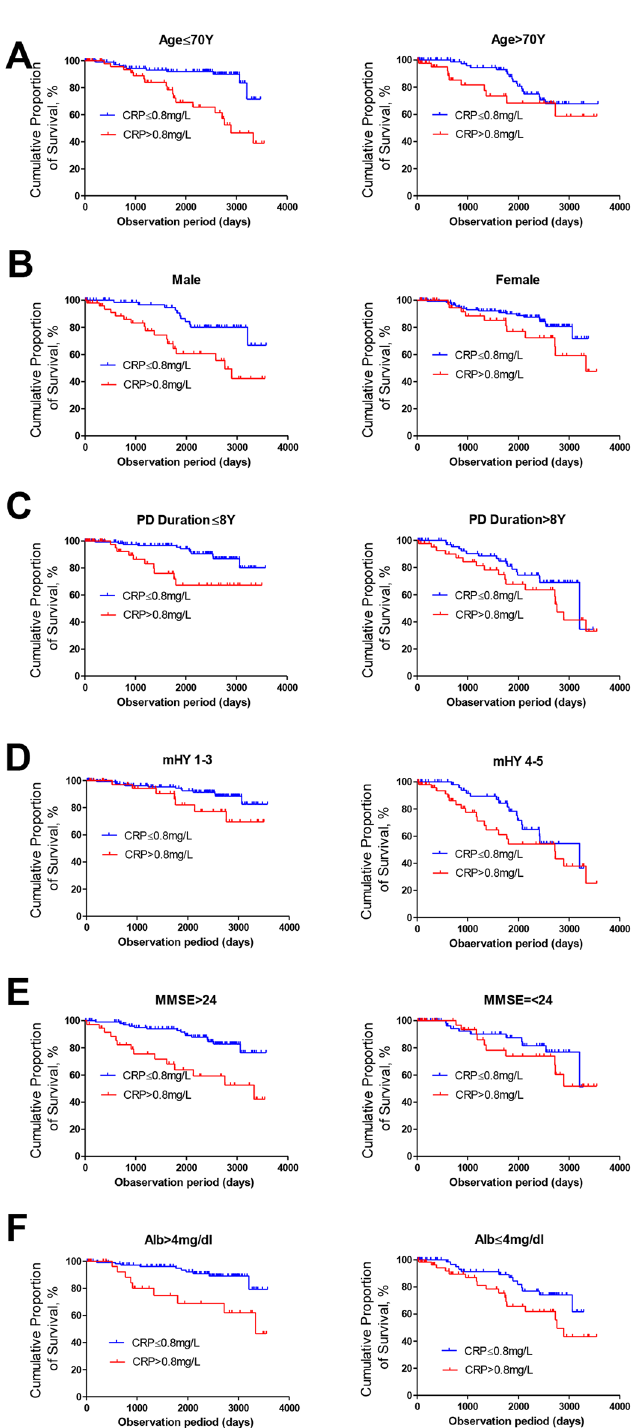
Fig 4. Survival curves of PD patients according to CRP levels. The cumulative survival rate was compared in patients with CRP (cid:1) 0.8 mg/L and those with CRP > 0.8 mg/L and was stratified by age (A), sex (B), PD duration (C), modified H-Y stage (D), MMSE (E), and serum albumin (F). The cumulative survival rate was significantly higher in patients with CRP (cid:1) 0.8 mg/L than those with CRP > 0.8 mg/L. Statistical significance was calculated in pooled